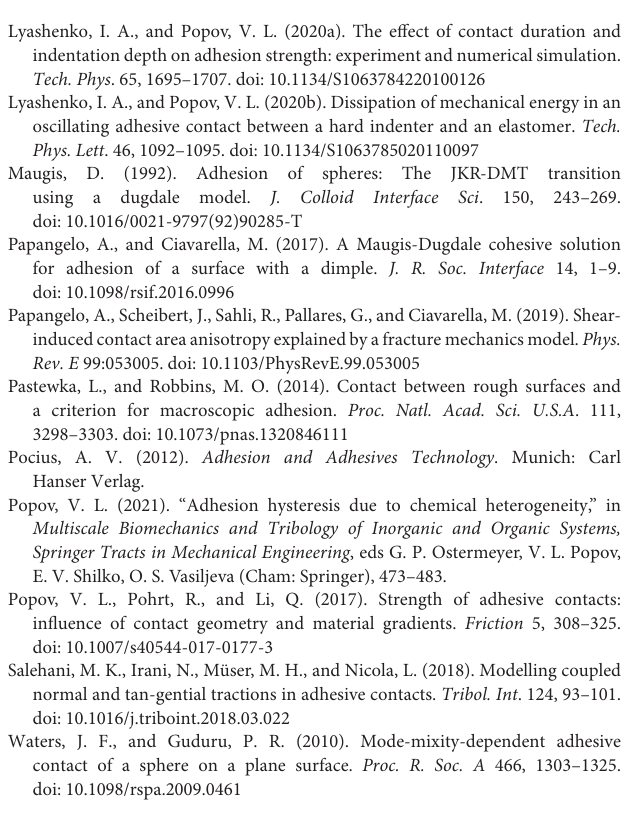
the dependencies of contact area, the experiment duration in seconds is shown. The movie corresponds to Figure 6 . Supplementary Video 5 | Video of simulation for indentation of rigid sphere with radius 100mm in an elastic layer with thickness of h = 5mm, Young modulus E = 0.283 MPa and Poisson’s ratio ν = 0.47. Solid particles with different geometrical shapes are located on the elastomer. Panels from left to right show the contact configuration and the dependencies of normal force and direct contact area between indenter and elastomer on the indentation depth. Surface energy in the indenting process is very small γ 0 = 0.0175 J/m 2 . In the pull-off phase, it is zero in the region where particles are located and γ 1 = 5 J/m 2 in the remaining region. In the second cycle, γ 1 = 2.7 J/m 2 . Contact zones are shown in different colors: black—noncontact area where no particle located; red—noncontact areas where particles located; green—area of direct contact between elastomer and indenter; blue—area of contact between indenter and particles. The movie corresponds to Figure 7 . Supplementary Video 6 | Video of experiment for indentation of a steel ball (indenter) with radius 100mm in a transparent rubber sheet TARNAC CRG N3005 with thickness of h = 10mm. The velocity of indenter movement is v = 0.676